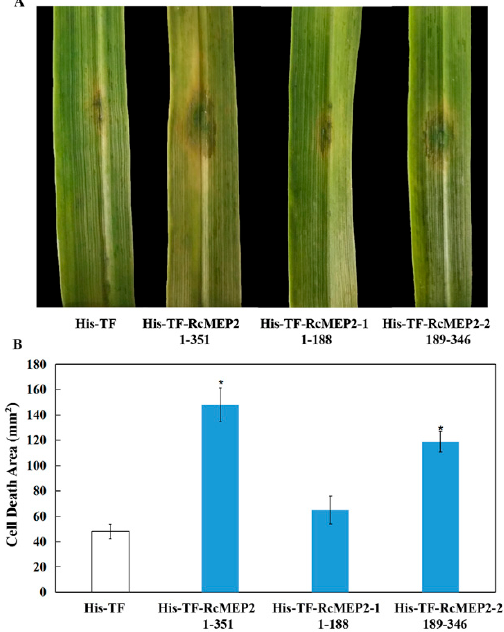
Figure 5. RcMEP2 and its M35 domain can induce cell death/necrosis in infiltrated wheat leaves. ( A ) Detection of the cell death-inducing activities of His-TF-RcMEP2, His-TF-RcMEP2-1, and His-TF-RcMEP2-2 in the infiltrated wheat leaves. ( B ) Areas of necrosis/cell death induced by RcMEP2 and its M35 domain-containing peptides on these wheat leaves. Asterisk * indicates significant difference between His-TF-RcMEP2 or His-TF-RcMEP2-2 treatment and His-TF (control, CK) treatment ( p < 0.05, t -test).